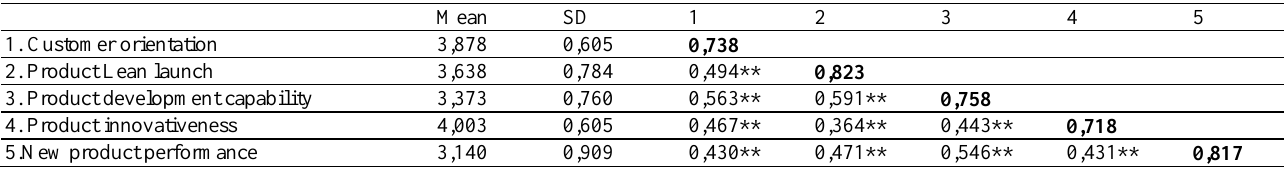
Table 3: Descriptive statistics and correlations